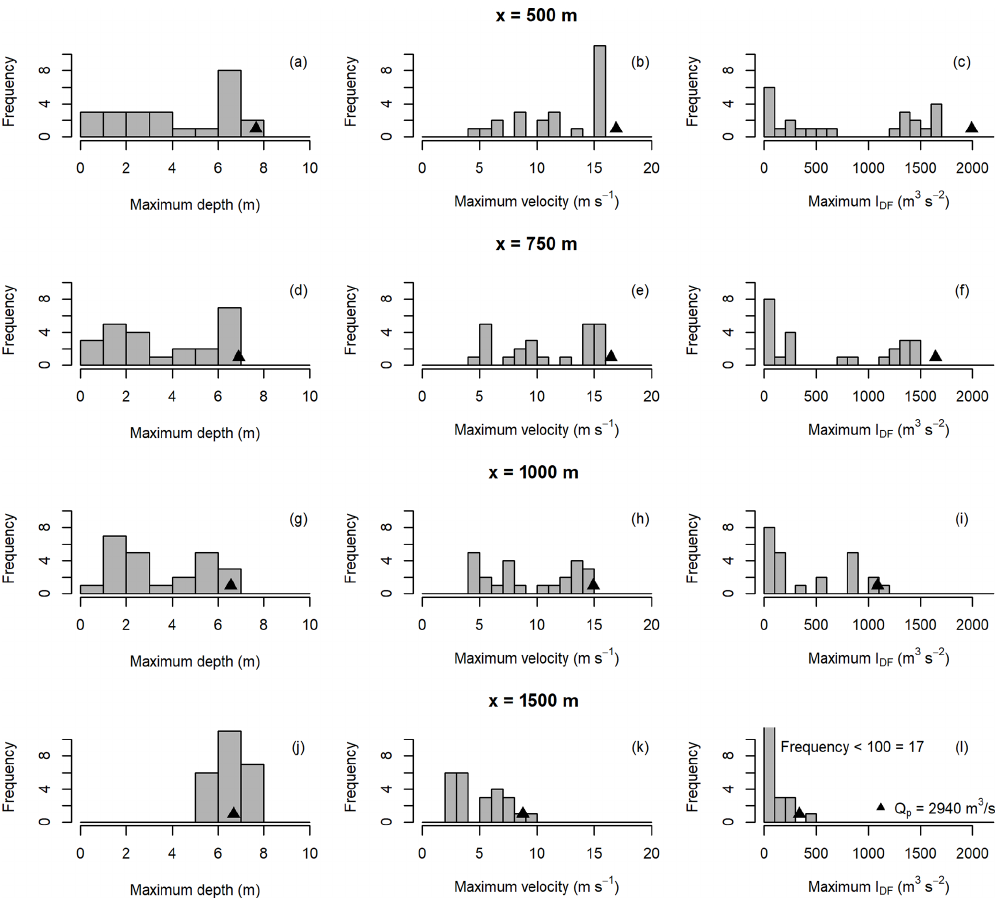
Figure 10. Comparison of modelled flow intensity indicators using consistent Voellmy parameters ( f = 0 . 2, ξ = 200ms − 2 ). Histogram bars indicate the distributions for the 24 real hydrographs modelled, all scaled to a volume of V = 100000m 3 and peak discharge of Q p ≤ 2940m 3 s − 1 . The single triangle points represent the results from the triangular hydrograph